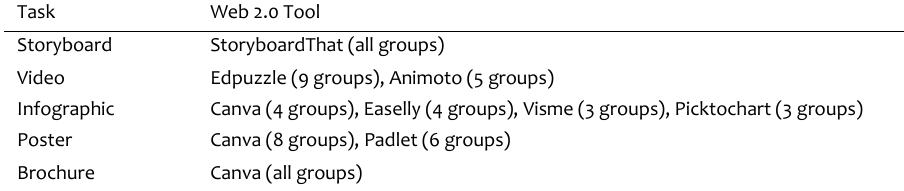
Table 1. Web 2.0 tools used in the